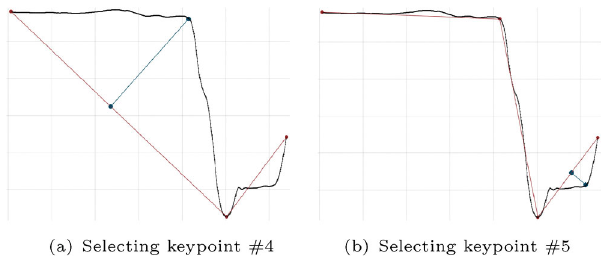
Fig. 3 Iterations performed by the Ramer–Douglas–Peucker (RDP) algorithm for identifying keypoints that summarize a curve [5, 18, 19]. In each iteration, the algorithm adds the keypoint furthest from the piecewise linear interpolation of the current set of